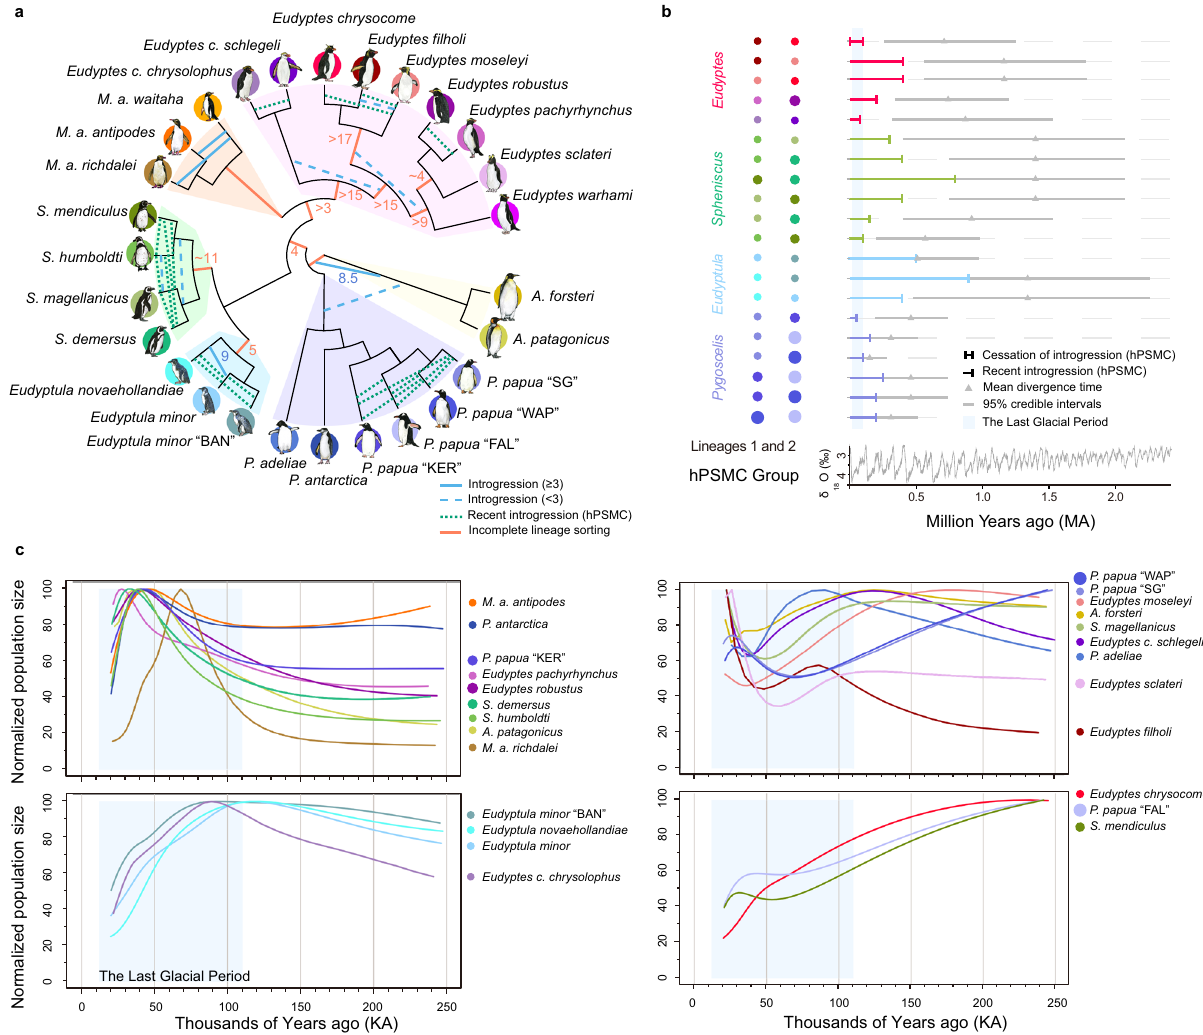
Fig. 2 Incomplete lineage sorting, introgression events, and demographic history among penguins. a Model of incomplete lineage sorting (ILS) and introgression events estimated from QuIBL and hybrid pairwise sequentially Markovian coalescent (hPSMC) results. hPSMC was only run for 20 species pairs (see b ). Numbers on branches represent the proportion (%) of ILS (orange branches) or introgression (blue lines, blue dashed lines, and blue dotted lines) detected by QuIBL. Proportions <3% were marked with blue dashed lines. Aqua dotted lines represent the ongoing gene fl ow detected by hPSMC. b Estimated divergence times and time intervals during which gene fl ow ceased between closely related lineages (see Supplementary Data 2 for details). Each circle represents one species in plot a. Gray lines represent the 95% credible intervals for the divergence times from the Bayesian total-evidence dating tree. Composite oxygen stable isotope ( δ 18 O) data were modi fi ed from 10 to show the climate fl uctuations. c Normalized inferred population size (as a percentage of the maximum population size for each species between 20 and 250 Kya) trends for four groups of species showing similar patterns during the LGP based on PSMC results (full PSMC results shown in Supplementary Fig. 11). WAP = West Antarctic Peninsula, SG = South Georgia, KER = Kerguelen, FAL = Falkland/Malvinas and BAN = Banks Peninsula. Source data is provided as a Source Data fi